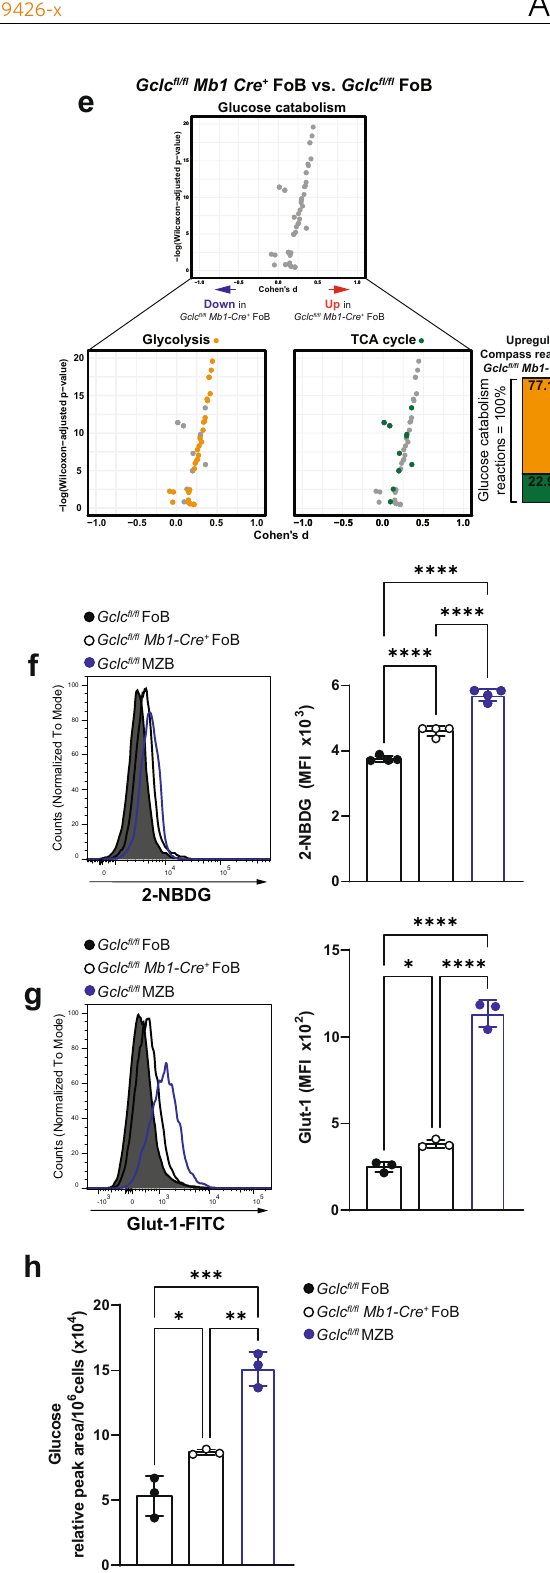
critical for the steady state function of mitochondria, whose staining to assess mitochondrial membrane potential ( ΔΨ m ) with fi tness is crucial for the maintenance of MZB. In FoB, we found fl ow cytometry. We found that Gclc de fi ciency increased ΔΨ m in mutant FoB compared to controls (Fig. 5k). However, loose that ATP levels in Gclc -de fi cient, but not in Gclc -suf fi cient FoB mitochondrial cristae have been associated with poor electron dropped in a dose-dependent fashion in response to inhibition of transport chain (ETC) ef fi ciency in T cells 77 , suggesting that other glycolysis with 2-deoxy-D-glucose (2-DG) or galactose (Fig. 5l and Supplementary Fig. 6i). In parallel, glycolysis inhibition factors might be responsible for the increased | ΔΨ m | in mutant FoB. Coupled with our data, this observation suggests that GSH is increased cell death in Gclc -de fi cient FoB to a stronger extent NATURE COMMUNICATIONS| (2022) 13:1789